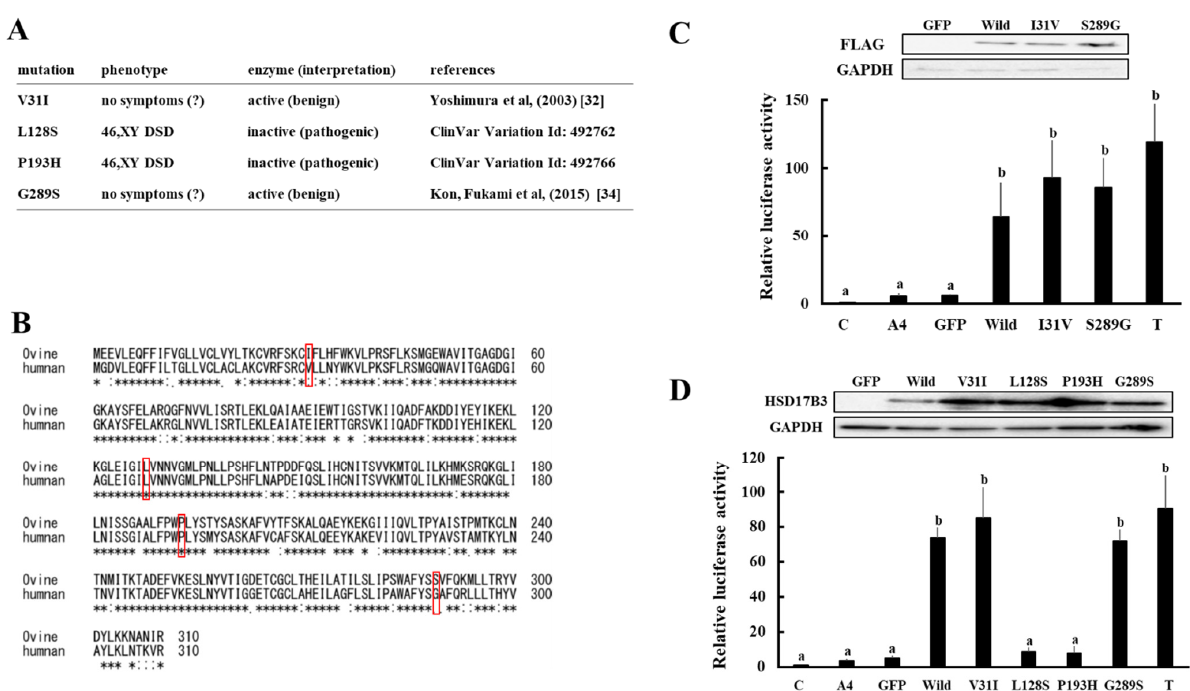
Figure 4. Enzymatic activities of missense mutations in ovine and human HSD17B3 genes. ( A ) Clinical symptoms and enzymatic activities of each mutation in the human HSD17B3 gene. ( B ) Comparison of the deduced HSD17B3 amino acid sequences of ovine and human. The asterix (*) are the conserved amino acids between both species. Amino acids that can mutate as shown in ( A ) are indicated by the boxes. ( C ) Upper panel shows Western blot analyses performed with the antibodies against FLAG-tag and GAPDH using lysates of GFP-, wild-type FLAG-tagged ovine HSD17B3- and FLAG-tagged each mutant HSD17B3-introduced HEK293 cells. Lower panel shows activation of ovine AR-mediated transcription by culture media from wild-type and mutant ovine HSD17B3-introduced HEK293 cells. CV-1 cells were transfected with ARE-Luc and ovine AR-expression vectors. At 24 h post-transfection, cells were incubated with vehicle ( C ), A4 (10 − 9 M), T (10 − 9 M), and each gene-expressing HEK293 cell’s culture medium collected at 2 h after A4 addition. Values of the vehicle were defined as 1. Data represent the mean ± SEM of four independent experiments. Values marked by the different letters are significantly different with each other ( p < 0.05). ( D ) Upper panel shows Western blot analyses that were performed with the antibodies against HSD17B3 and GAPDH using lysates of GFP-, wild-type human HSD17B3-, and each mutant HSD17B3-introduced HEK293 cells. Lower panel shows activation of human AR-mediated transcription by culture media from wild-type and mutant human HSD17B3-introduced HEK293 cells. CV-1 cells were transfected with ARE-Luc and ovine AR-expression vectors. At 24 h post-transfection, cells were incubated with vehicle ( C ), A4 (10 − 9 M), T (10 − 9 M), and each gene-expressing HEK293 cell’s culture medium collected at 2 h after A4 addition. Values of the vehicle were defined as 1. Data represent the mean ± SEM of four independent experiments. Values marked by the different letters are significantly different with each other ( p < 0.05).